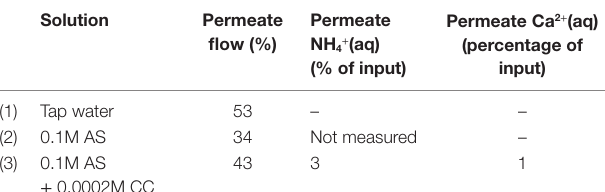
TaBle 5 | experimental results obtained with the rO device.